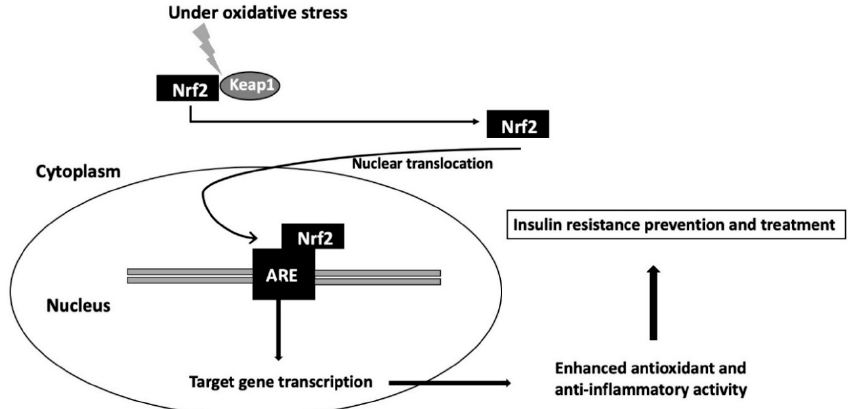
Figure 1. Nrf2 signaling pathway. Nrf2 bound to Keap1 in cytoplasm during low stress states is